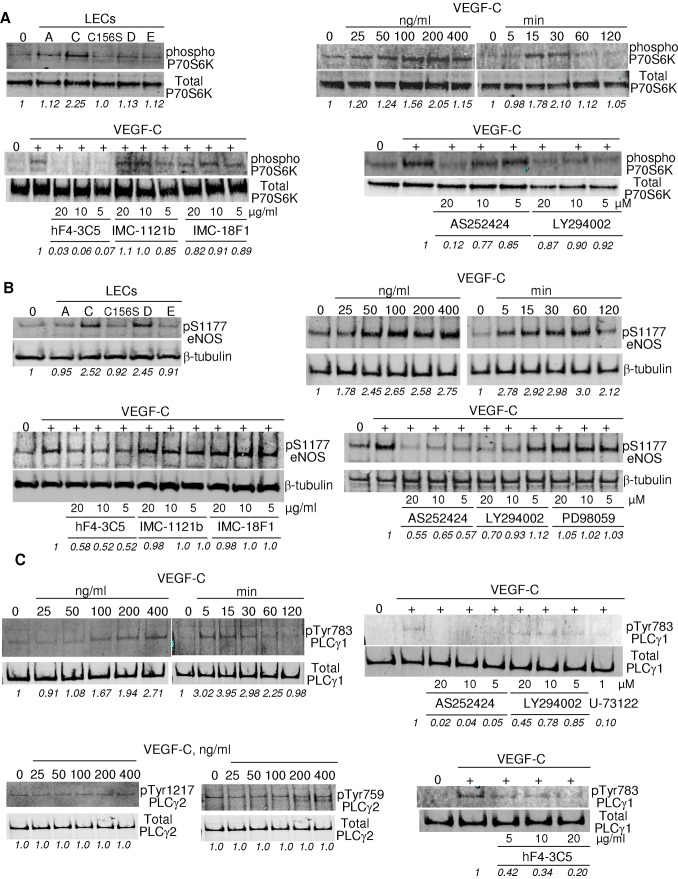
VEGF-C induces PI3Kγ-dependent P70S6K (A), eNOS (B), and PLCγ1 (C) phosphorylation via VEGFR-3 in LECs.Western blotting analysis of phosphorylated P70S6K (A, top left) and eNOS (S1177) (B, top left) in prostatic LECs following 15 minute stimulation with ligand: VEGF-C (100 ng/ml), VEGF-A (100 ng/ml), VEGF-C156S (250 ng/ml), VEGF-D (250 ng/ml) and VEGF-E (100 ng/ml). Time- and concentration-dependent phosphorylation of P70S6K (A, top right), eNOS (S1177) (B, top right), and PLCγ1 (Tyr783) (C, top left) in LECs in response to VEGF-C. The effect of inhibition of VEGFR-3 (hF4-3C5), VEGFR-2 (IMC-1121b) or VEGFR-1 (IMC-18F1) on phosphorylation of P70S6K (A, bottom left), eNOS (S1177) (B, bottom left); and VEGFR-3 (hF4-3C5) on PLCγ1 (Tyr783) (C, bottom right) on LEC response to VEGF-C (100 ng/ml). The effect of AS252424, LY294002, PD98059, and U-73122 on phosphorylation of P70S6K (A, top right), eNOS (S1177) (B, bottom right), and PLCγ1 (Tyr783) (C, bottom right) on LECs in response to VEGF-C. The effect of VEGF-C on phosphorylation of PLCγ2 (Tyr759, Tyr1217) in LECs (C, bottom left). Control serum-free vehicle treated LEC lysate is indicated by ‘0′ in all blots. n = 3. Densitometry analysis is shown under each blot in italics; where integrated intensity of phosphorylated molecules was firstly compared to that of the total target protein for each sample, and then expressed as fold change in integrated density compared to either serum-free (A, top left and right panels; B, top left and right panels; C, top and bottom left panels) or VEGF-C treated control samples (A, bottom left and right panels; B, bottom left and right panels; C, bottom and bottom left panels).